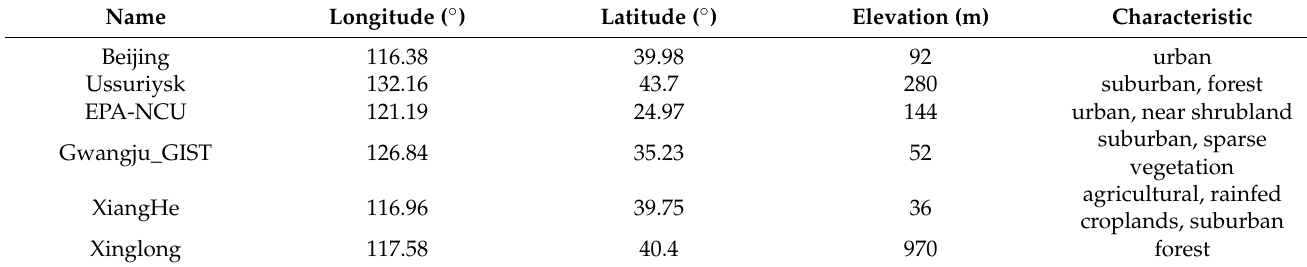
Table 2. Six AERONET stations used for aerosol retrieval validation in Eastern Asia, their geographic locations and land cover